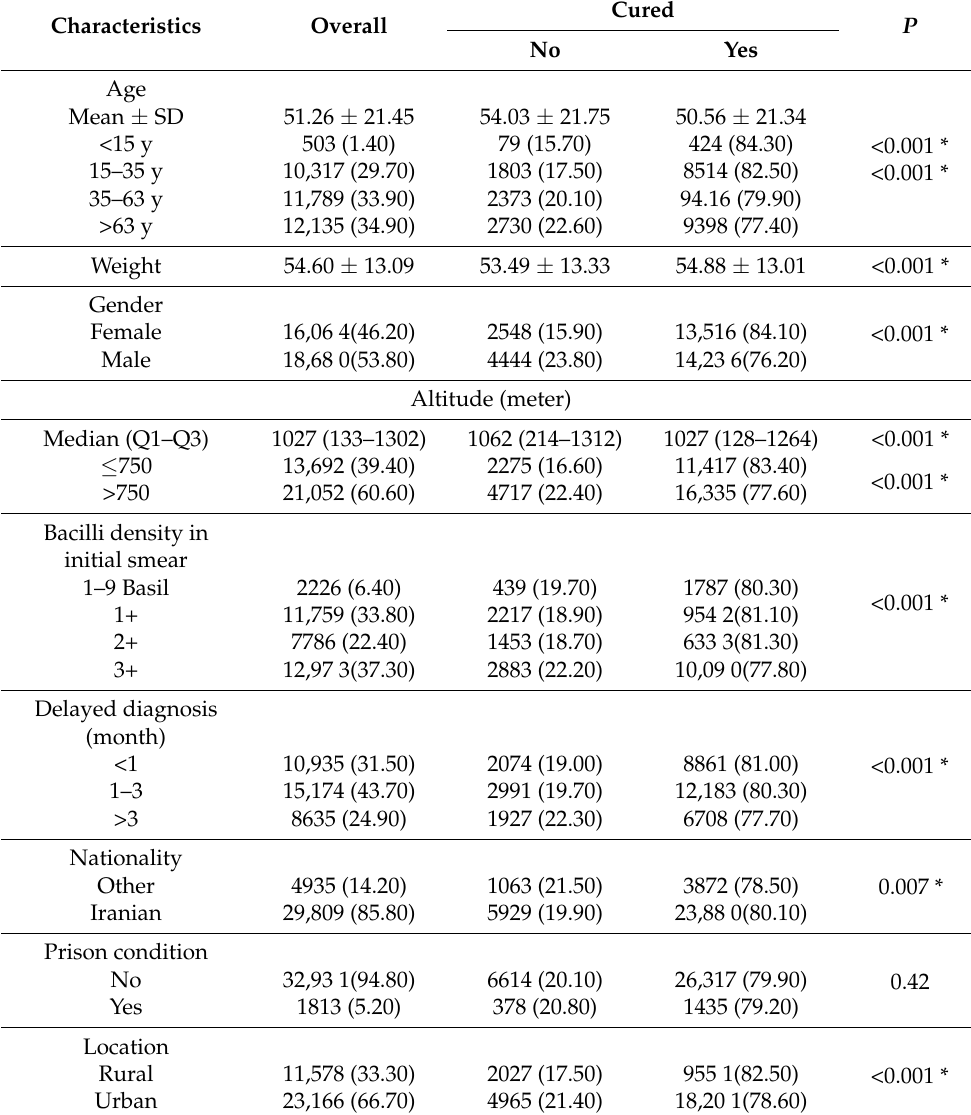
Table 1. Baseline characteristics of the new smear-positive PTB patients in Iran (n = 34,744) and results of single risk factor analysis.